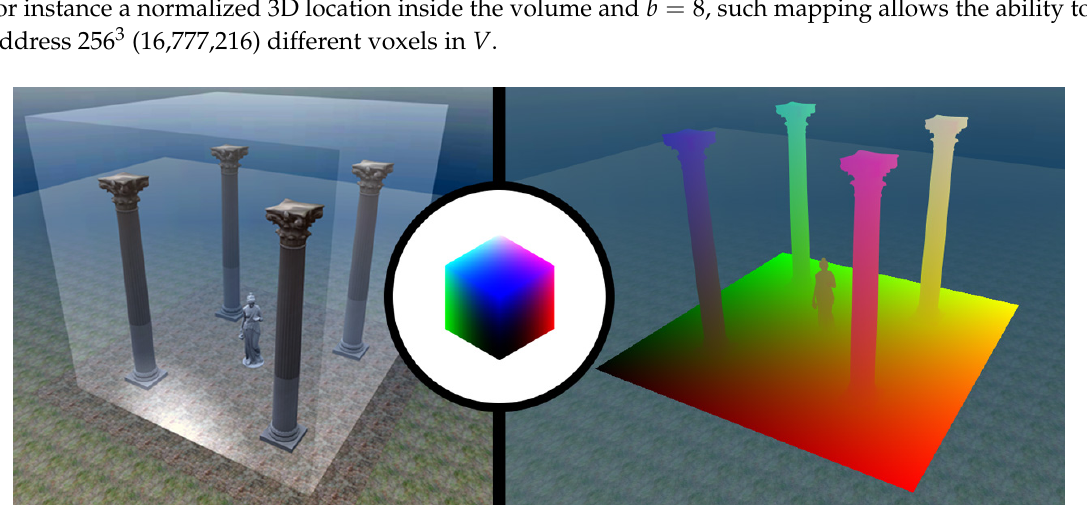
Figure 1. ( Left ) A single session volume arranged in a sample immersive virtual environment (IVE). ( Right ) A sample visualization of color-coded locations of the same IVE using the spatial quantizer (Definition 2). Each location inside the volume can thus be translated into a color and vice versa.